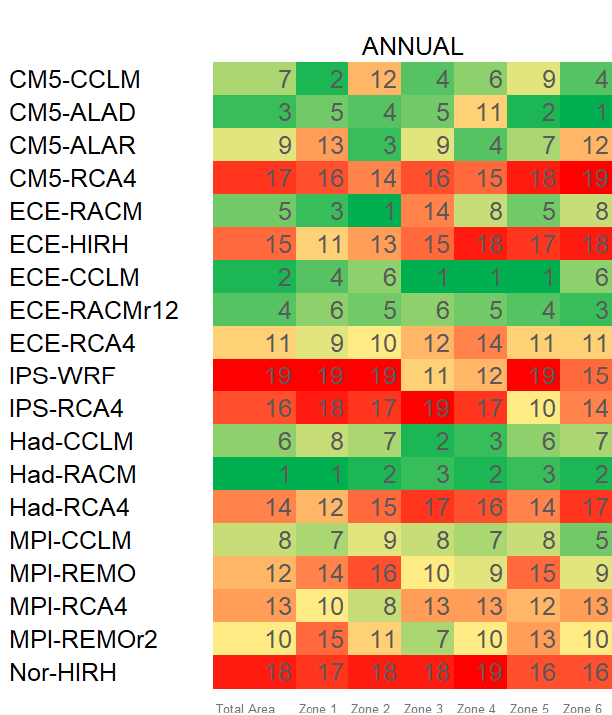
Figure 6. (a) As Fig. 2a but for annual precipitation. (b) As Fig. 2b but for annual precipitation.